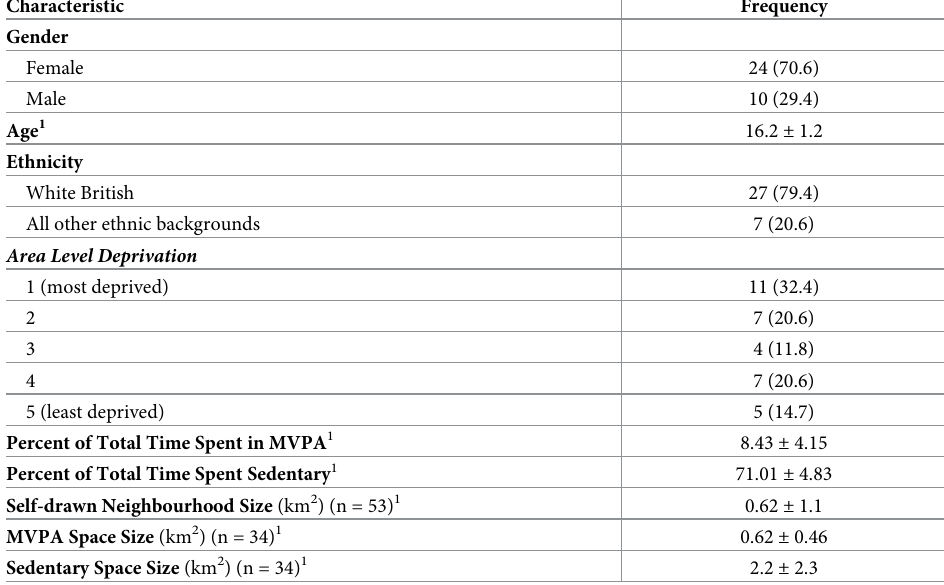
Table 1. Study sample characteristics (n =